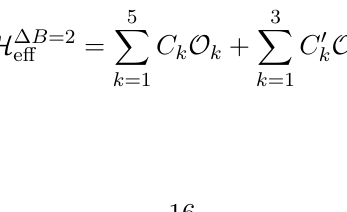
Figure 6. Contour plot of the allowed 2HDM-II parameter space in the (tan β − m originating from the combination of tree-level leptonic and semi-leptonic decays of B, B s , D, D s , K , and π mesons and the hadronic decays of τ leptons to K and π mesons with a tau neutrino as well as R ( D ) and R ( D ∗ ) , see table 6. The lighter contour indicates the allowed parameter space at 2 σ confidence level while the darker contour corresponds to 1 σ